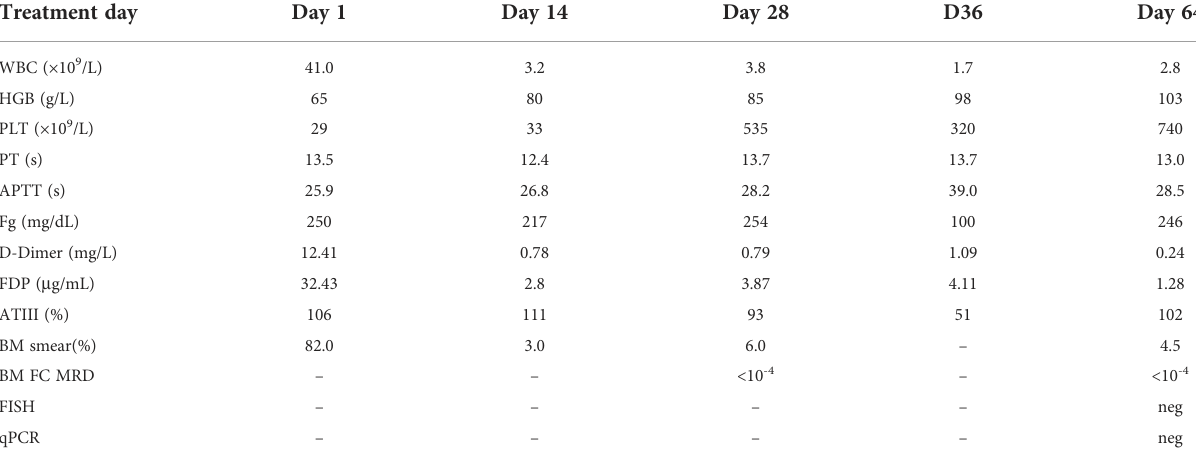
TABLE 1 Blood cell counts, percentage of promyelocytes upon bone marrow smear, bone marrow MRD by fl ow cytometry, FISH, and qPCR detection of TBL1XR1-RARB fusion during the course of treatment. Treatment